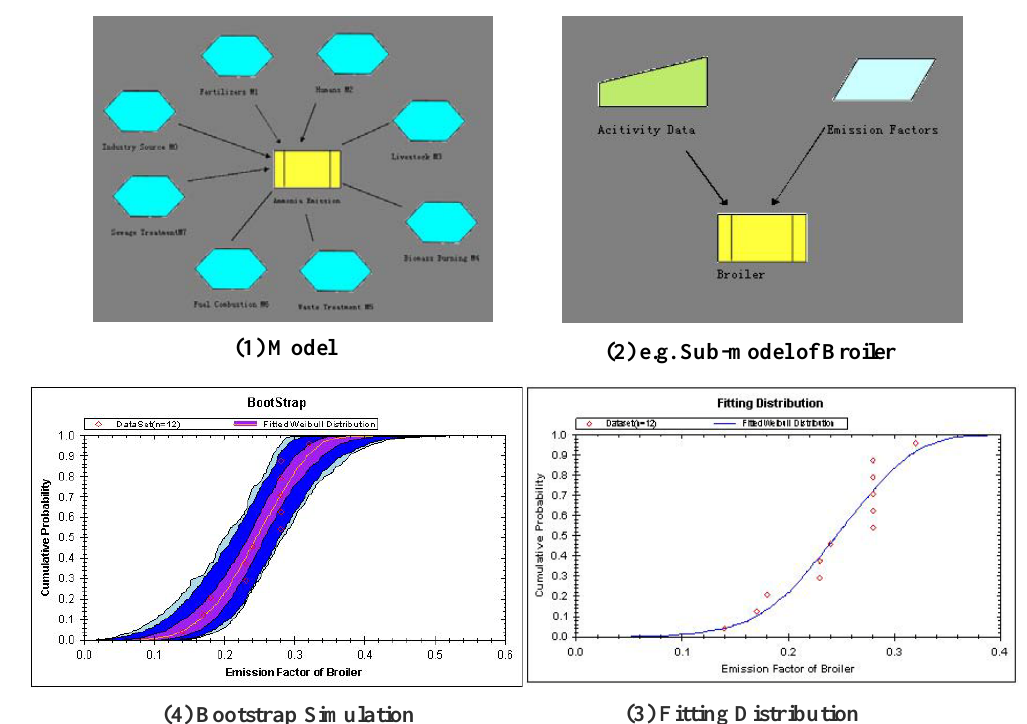
Fig. 2. The model framework for analyzing uncertainty in emission estimates by the AuvToolPro.